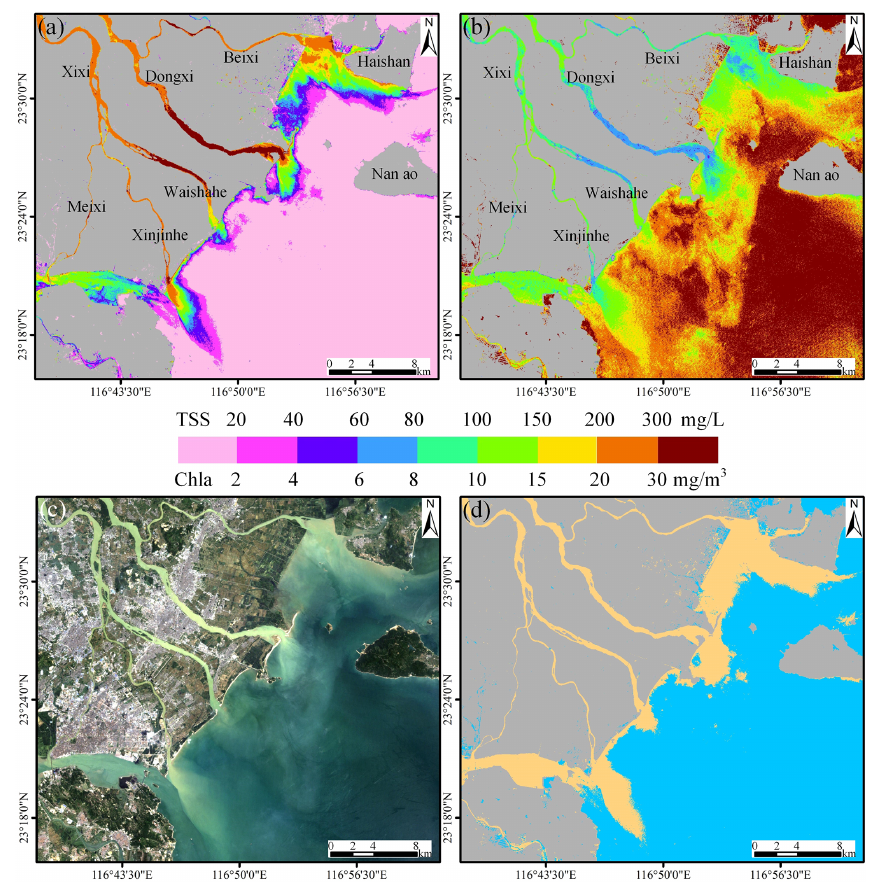
Figure 9. The estimated TSS concentrations (a) , Chl a concentrations (b) , true color imagery (USGS, 1982; NASA, 2001) (c) , and extracted TMZ results, indicated by mango coloring, (d) in the HRE on 13 August 2008 (high-flow